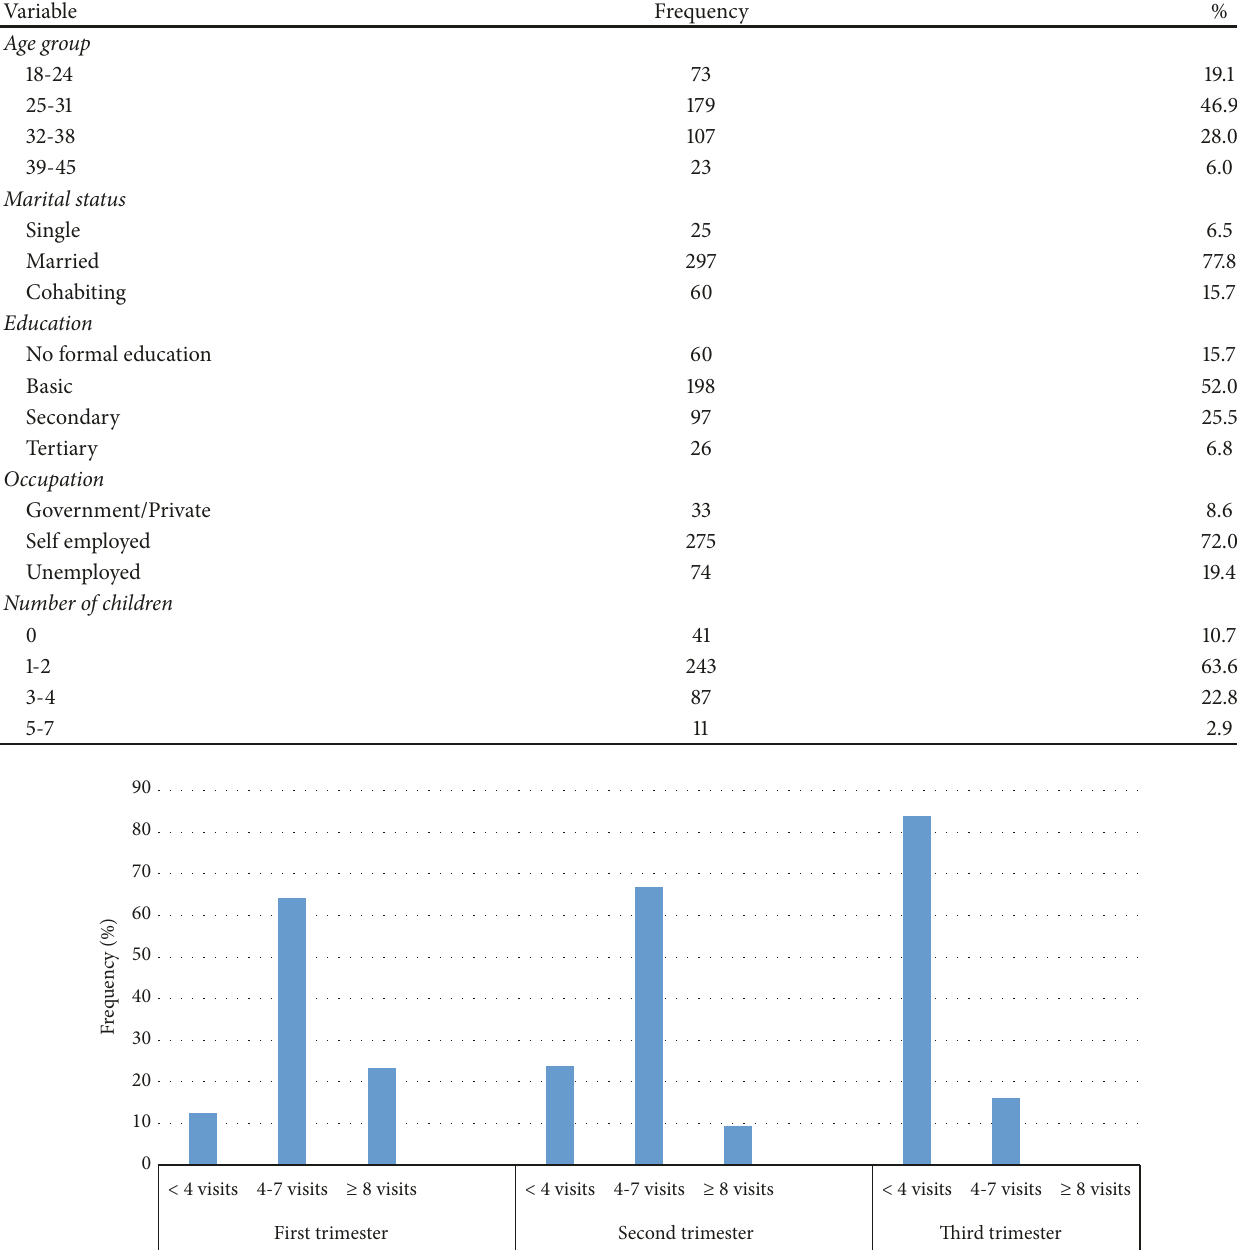
Table 1: Sociodemographic characteristics of study participants.